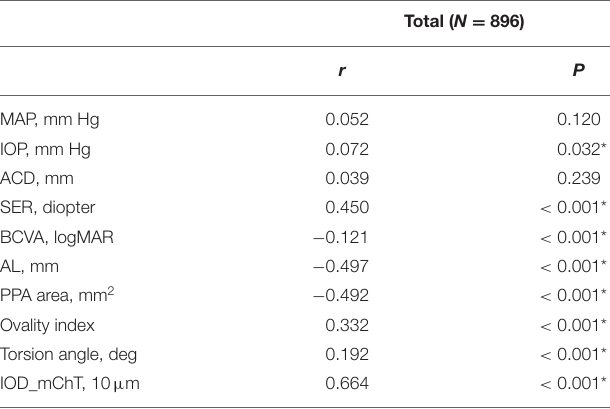
TABLE 5 | Partial correlation analysis between peripapillary choroidal thickness and features of the optic disc adjusted for sex and age in all subjects.